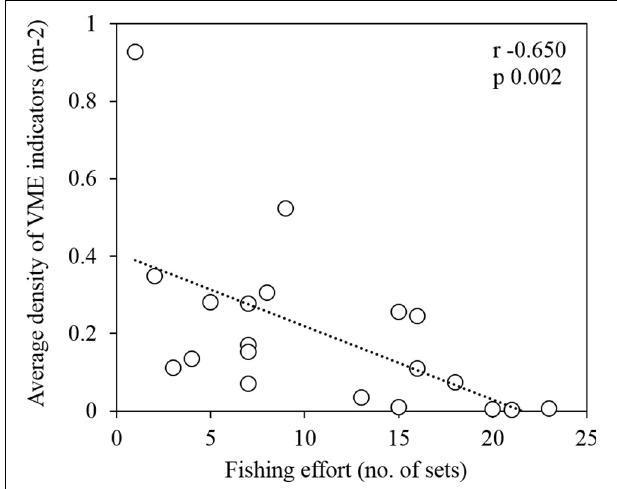
FIGURE 10 | A significant negative correlation between the average density of vulnerable marine ecosystem (VME) indicators (m − 2 ) and the fishing effort (number of transecting longline sets) within grid cells of 500 m by 500 m (Spearman test r –0.650, n 20, p